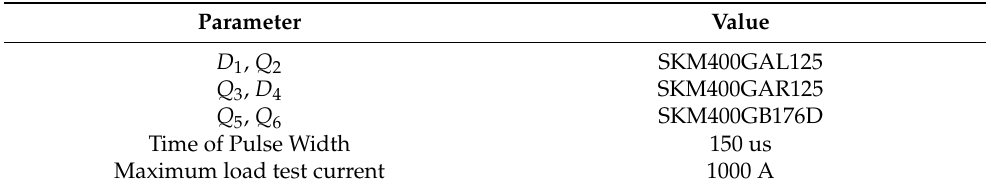
Figure 18a is the real dynamic characteristic test object of the laminated busbar.